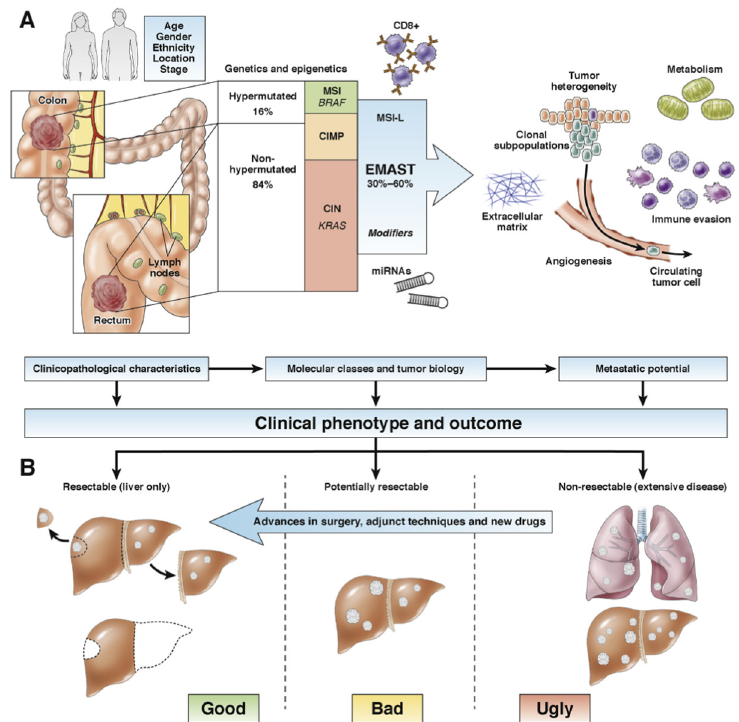
Figure 1. Clinical and molecular influence on the aggressiveness of colorectal liver metastasis. ( A ) Clinical behavior of colorectal cancer is determined by several factors, including demographic data (age, gender, and race), tumor presentation (location and stage), and timing of presentation of metastasis (synchronous or metachronous). Embedded in the cancer cells are the molecular pathways, which follow distinct forms of genomic instability yet with partly overlapping areas. Hypermutated cancers belong to the microsatellite instable (MSI) cancers and in part the CpG- island methylator phenotype (CIMP) cancers. Nonhypermutated cancers follow in large part the chromosomal instability (CIN)–driven pathways, often involving KRAS mutations from an